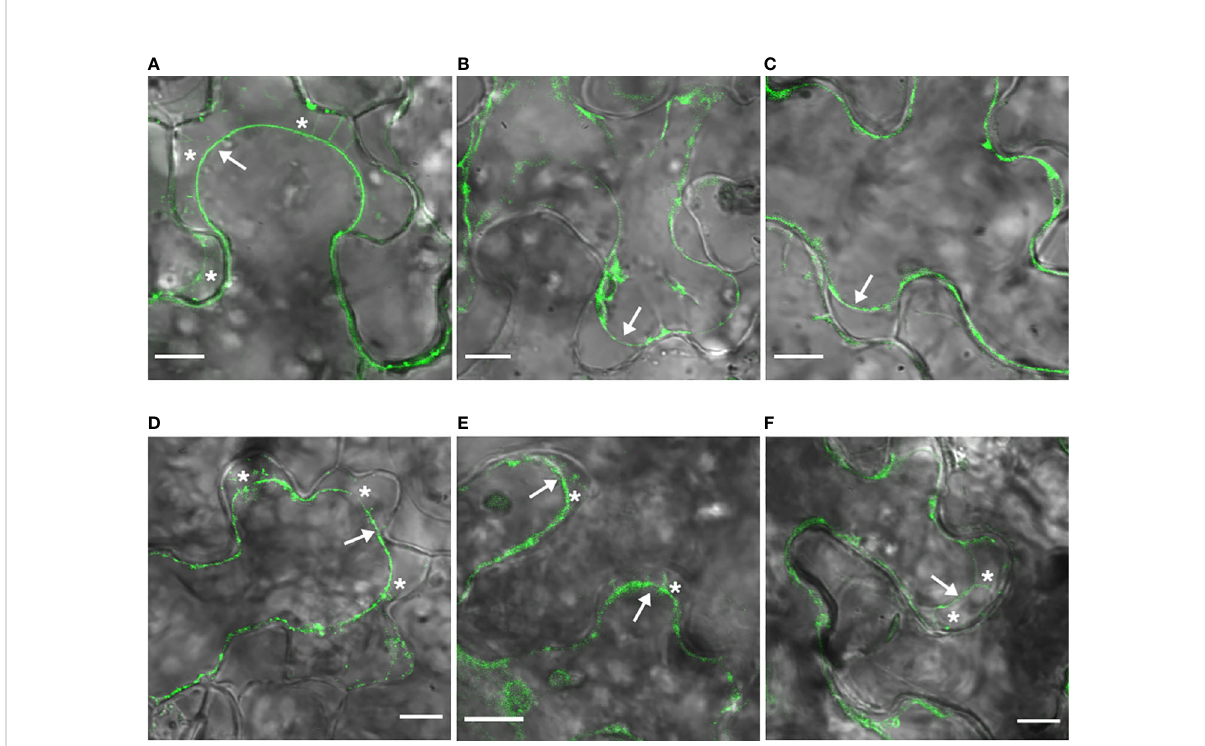
FIGURE 4 LL motif MP mutants are targeted to the plasma membrane. N. benthamiana epidermal cells expressing GFP : MPwt (A) or GFP : MP mutants, GFP : MP_Y (B) , GFP : MP_Y/G (C) , GFP : MP_D/G (D) , GFP : MP_D (E) , and GFP : MP_LI/GG (F) along with RdRp and CP. were plasmolyzed with 1M mannitol. Arrows show the retracted plasma membrane and asterisks denote Hechtian strands. Images were taken at 62-66 hpi and represent single optical planes. Scale bar, 10 m